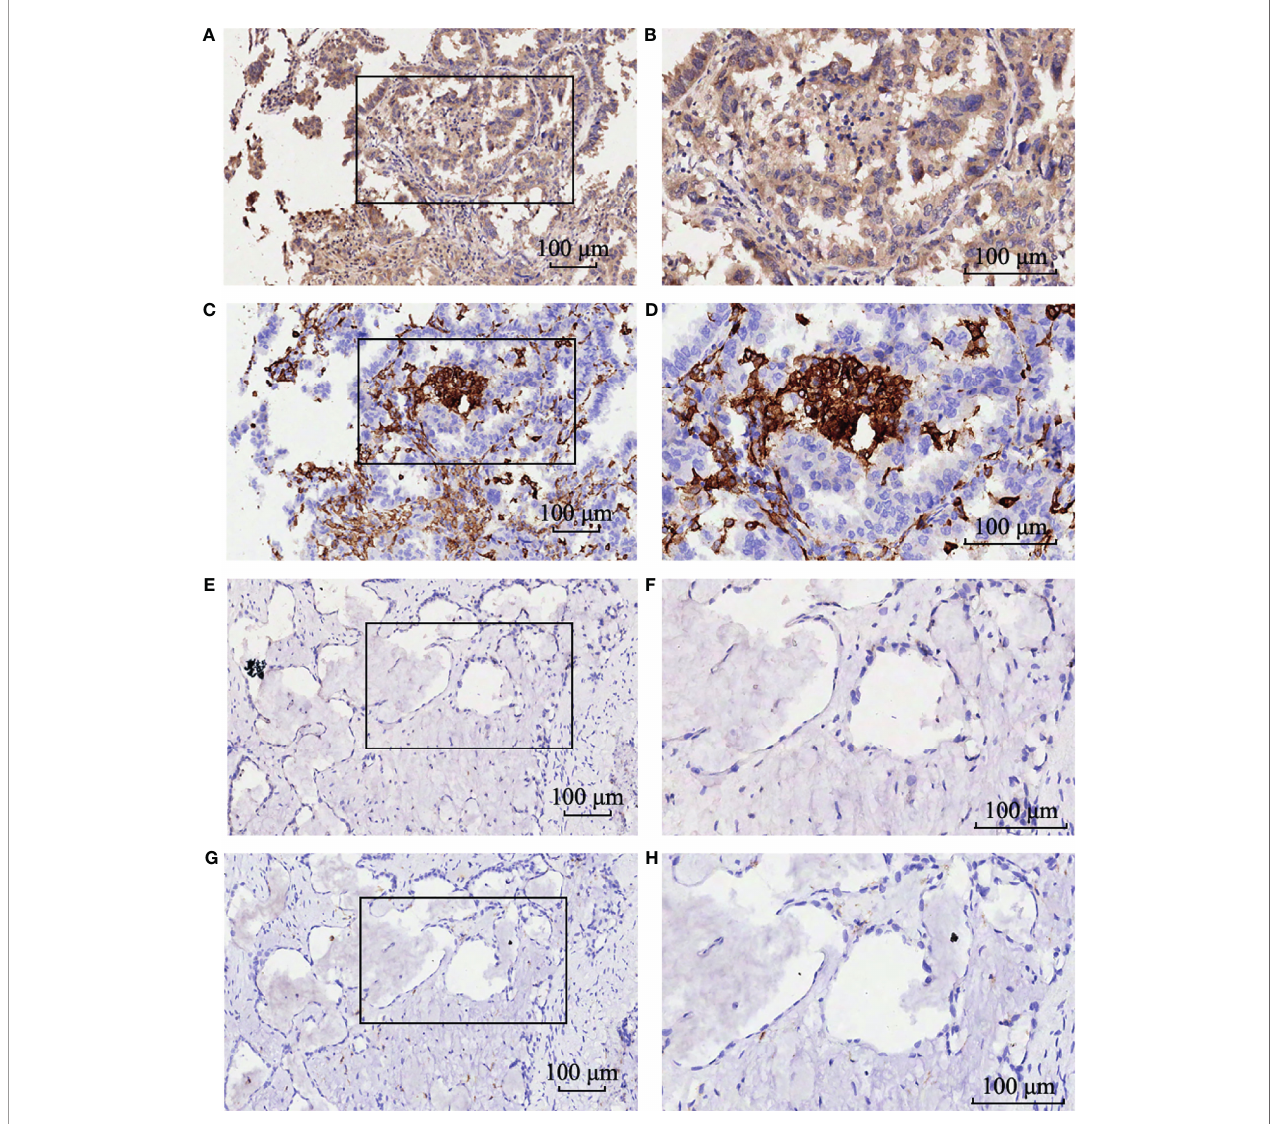
FIGURE 8 | The immunohistochemistry staining of GBE1 and CD163 in the same LUAD tissue samples. Strong intensity of GBE1 in LUAD tissue (A) low magni fi cation and (B) high magni fi cation. Strong intensity of CD163 in LUAD tissue (C) low magni fi cation and (D) high magni fi cation. Weak intensity of GBE1 in LUAD tissue (E) low magni fi cation and (F) high magni fi cation. Weak intensity of CD163 in LUAD tissue (G) low magni fi cation and (H) high magni fi